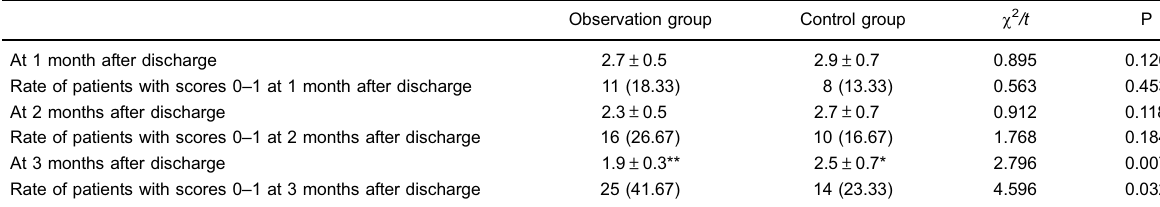
Table 5. Comparison of modi fi ed Rankin scale scores of patients with acute cerebral infarction treated with alteplase (observation group) or batroxobin (control